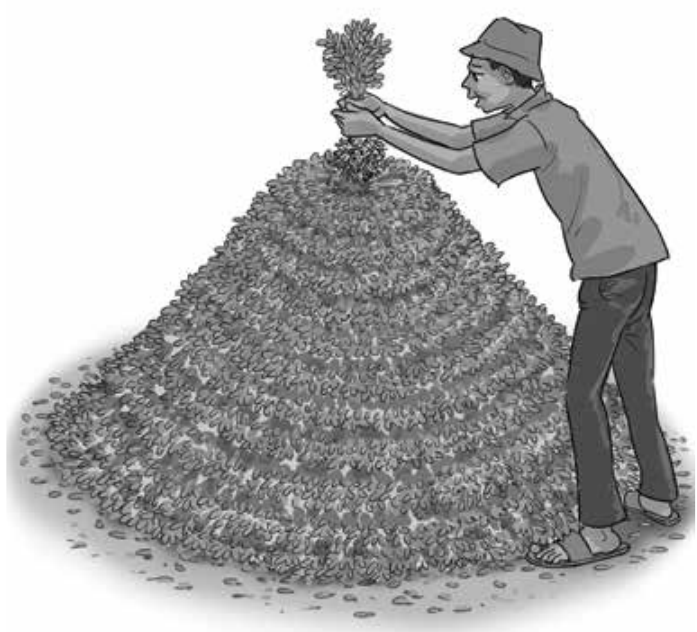
Figure 5: Completing a Mandela cock – plugging the small opening with a groundnut plant, pods positioned down into the